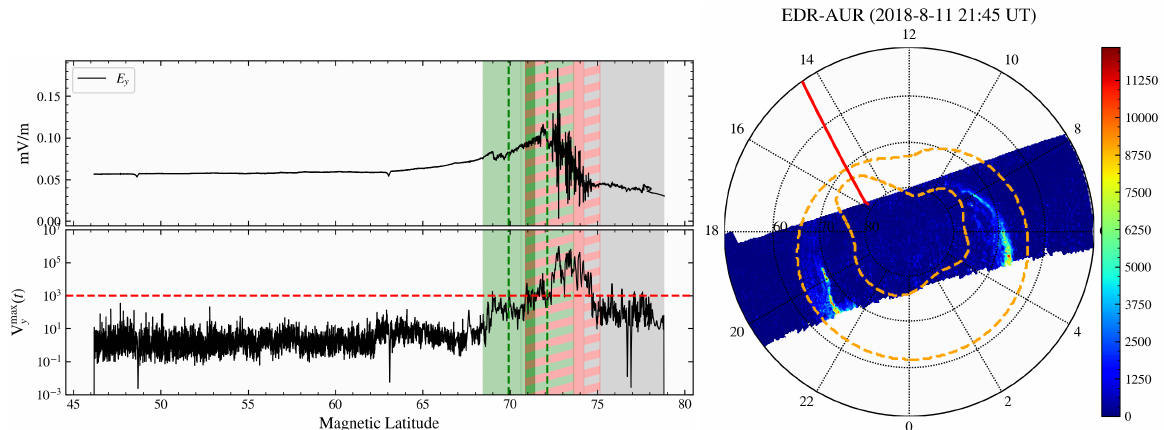
Figure 12. Same as Figure 7, except for orbit 2898. Positive detection, dayside Northern hemisphere.